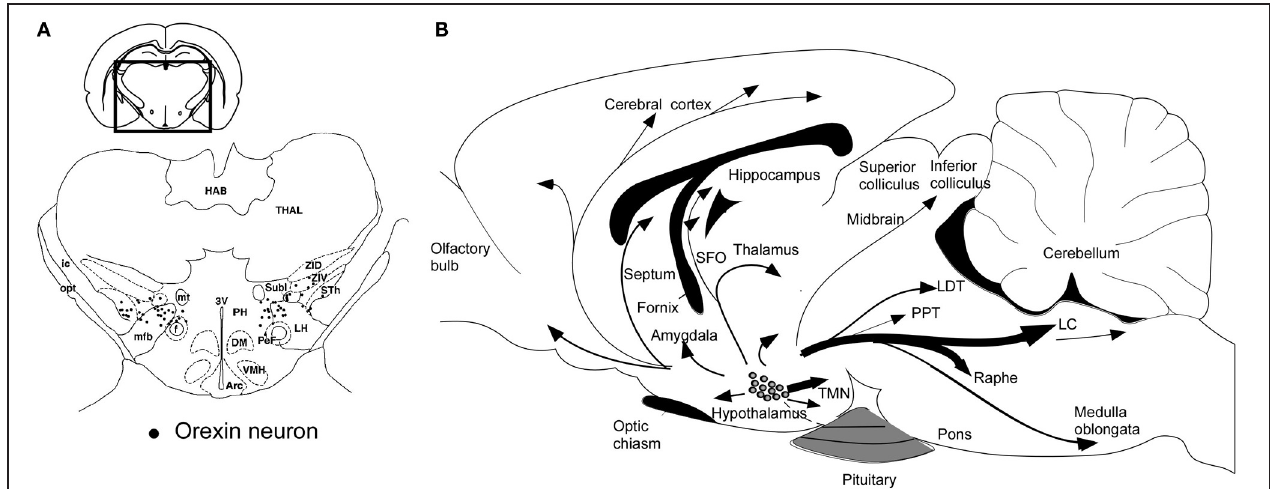
FIGURE 2 | Schematic drawing of coronal section and sagittal section through rat brain, summarizing the orexin neuronal system. (A) Prepro-orexin mRNA-containing neurons are shown in black superimposed upon anatomical structures of the hypo- and subthalamic areas. The rectangle designates the area schematized in the figure. Abbreviations: LH, lateral hypothalamic area; PeF, perifornical nucleus; PH, posterior hypothalamic area; Sth, subthalamic nucleus; SubI, subincertal nucleus; ZIV, ventral zona incerta. Additional landmarks include: THAL, thalamus; HAB, habenular complex; ic, internal capsule; opt, optic tract;